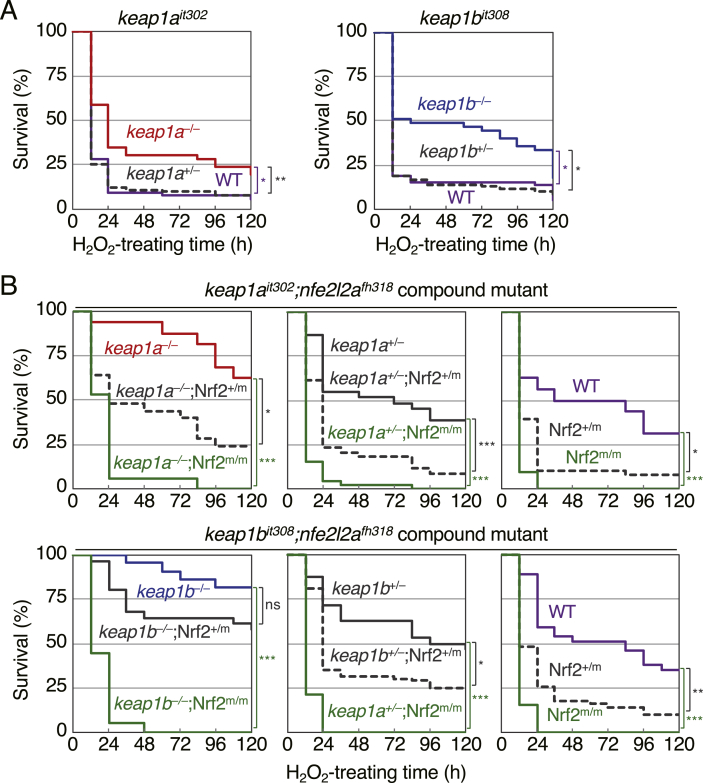
Survival assays ofkeap1a-andkeap1b-knockout larvae against H2O2.(A) The survival rate of keap1ait302 and keap1bit308 larvae after exposure to H2O2. At 4 dpf, larvae were exposed to 2 mM of H2O2, and the survival was observed every 12 h until 9 dpf. Tested numbers were as follows: keap1ait302 (WT n = 53, +/– n = 99, −/− n = 46), keap1bit308 (WT n = 59, +/– n = 107, −/− n = 45). Data from four independent experiments were combined.(B) The survival rate of keap1ait302;nfe2l2afh318 and keap1bit308;nfe2l2afh318 compound mutant larvae. Tested numbers were follows: keap1ait302;nfe2l2afh318 (−/−;WT n = 16, −/−; +/m n = 25, −/−;m/m n = 17, –/+; WT n = 31, –/+; m/+ n = 94, –/+; m/m n = 45, WT; WT n = 16, WT; +/m n = 38, WT; m/m n = 21), keap1bit308;nfe2l2afh318 (−/−;WT n = 22, −/−; +/m n = 31, −/−;m/m n = 18, –/+; WT n = 32, –/+; m/+ n = 79, –/+; m/m n = 37, WT; WT n = 37, WT; +/m n = 50, WT; m/m n = 26). Data from four independent experiments were combined. Asterisks indicate significant differences (*p < 0.05, **p < 0.01, ***p < 0.001).